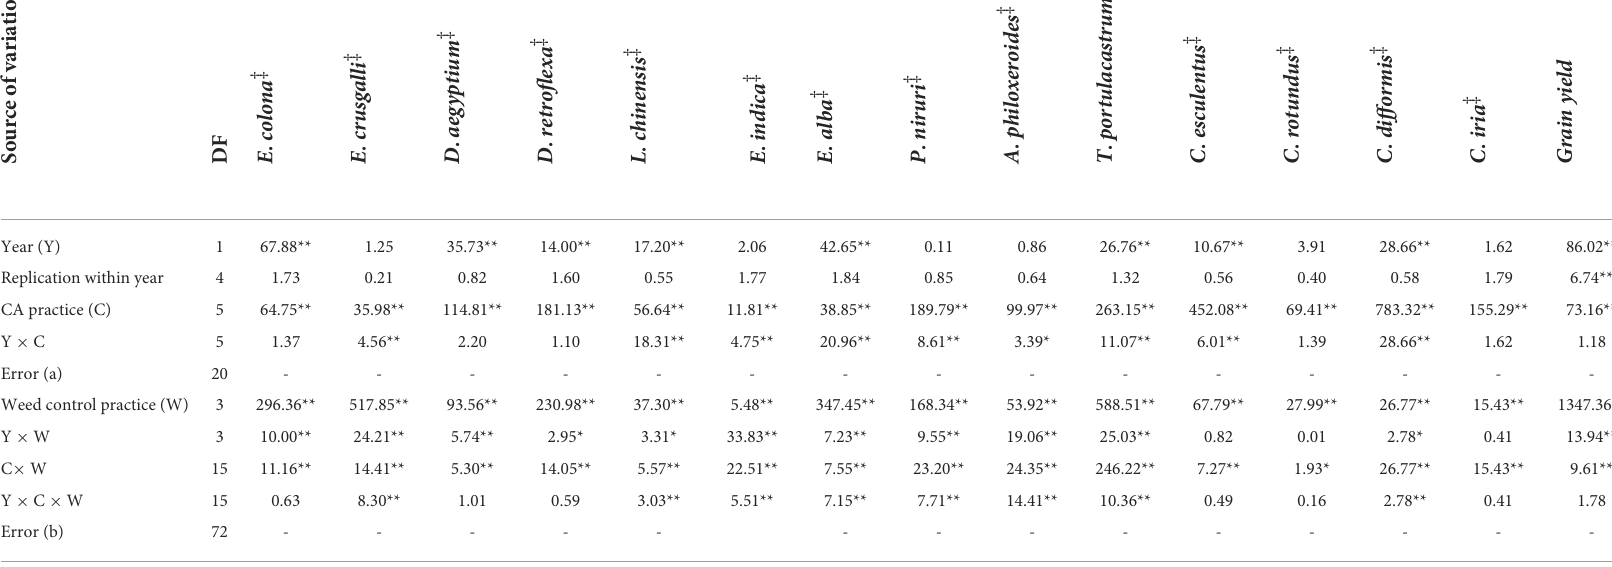
TABLE 3 Pooled analysis of variance (ANOVA) of Echinochloa colona, Echinochloa crusgalli, Dactyloctenium aegyptium, Dinebra retroflexa, Leptochloa chinensis, Eleusine indica , Eclipta alba, Phyllanthus niruri, Alternanthera philoxeroides, Trianthema portulacastrum , Cyperus esculentus , Cyperus rotundus, Cyperus difformis , Cyperus iria and grain yield showing the effects of years, CA and weed control practices and their